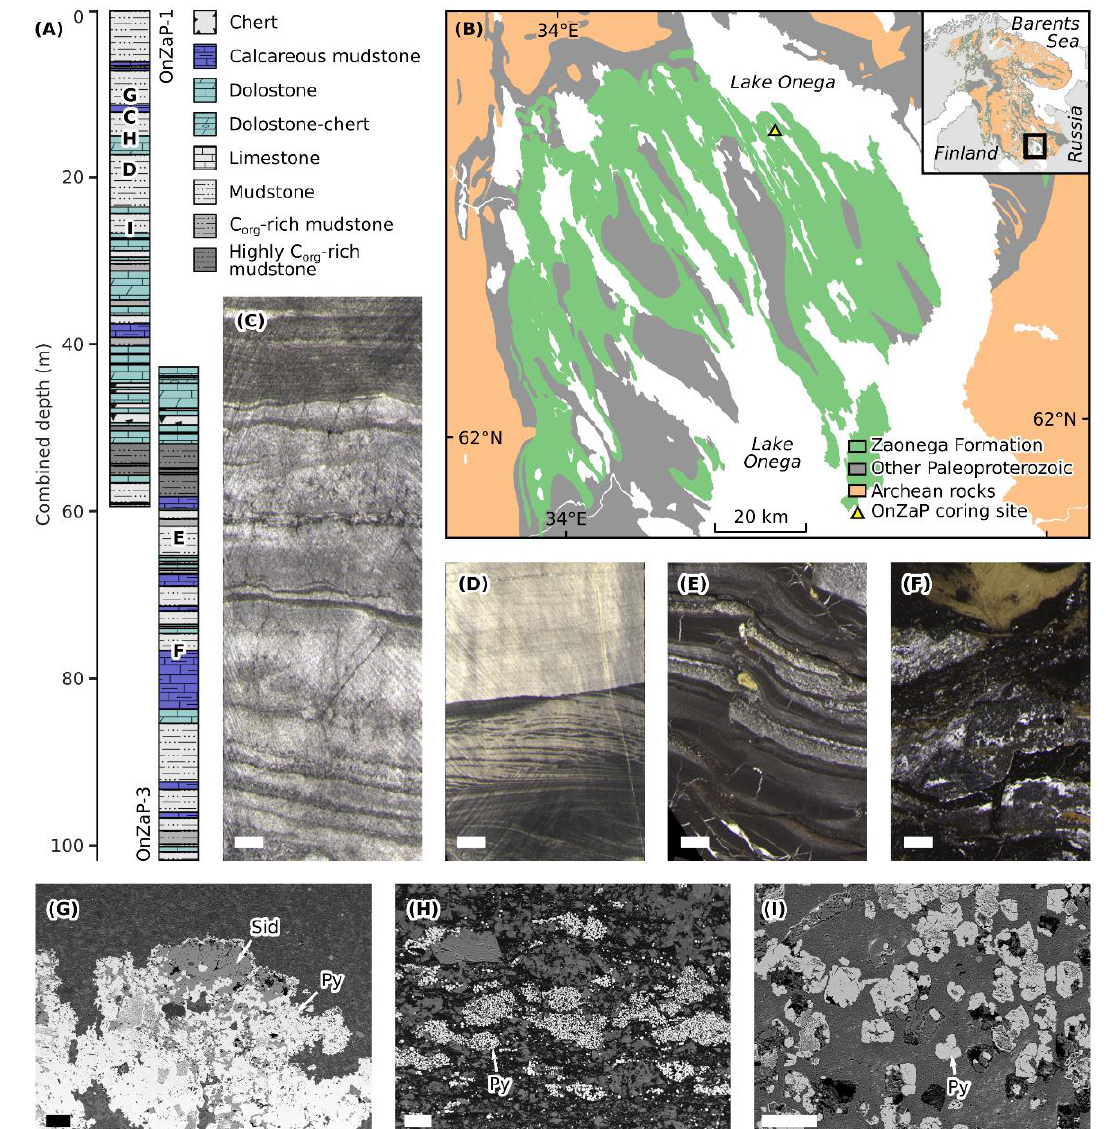
Figure 1. ( A ) Stratigraphic columns and lithological legend of the OnZaP section. Letters denote approximate locations of samples depicted in further panels. ( B ) Simplified geological map of the Onega Basin showing the exposure of the Zaonega Formation and the OnZaP coring site. ( C – F ) Representative drill core photographs [15]. Scale bars are 1 cm across. ( C ) Laminated fine-grained dolomite at 13.4 m depth. ( D ) Laminated grey mudstone with rare crossbedding at 19.38 m depth. ( E ) Laminated organic- and sulphide-rich mudstone displaying soft-sediment deformation as well as quartz-mica and pyrobitumen veining at 63.4 m depth. ( F ) Highly silicified mudstone displaying deformation, intense veining, and secondary pyrite at 76.5 m depth. ( G – I ) Scanning electron micrographs (back-scattered electrons) of authigenic Fe-bearing phases in the OnZaP section. Scale bars are 100 µm across. ( G ) Pyrite (bright backscatter) and siderite (medium grey backscatter) aggregate hosted in quartz-mica-carbonate matrix at 12.39 m depth. ( H ) Clusters of minute early diagenetic pyrite crystals in an organic-rich matrix at 14.31 m depth. ( I ) Larger late-stage pyrite crystals replacing precursor mineral phases in a quartz-mica-carbonate matrix at 26.8 m depth.